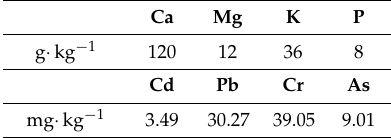
Table 1. Nutrient and heavy metal concentrations of the wood ash used for the experiment